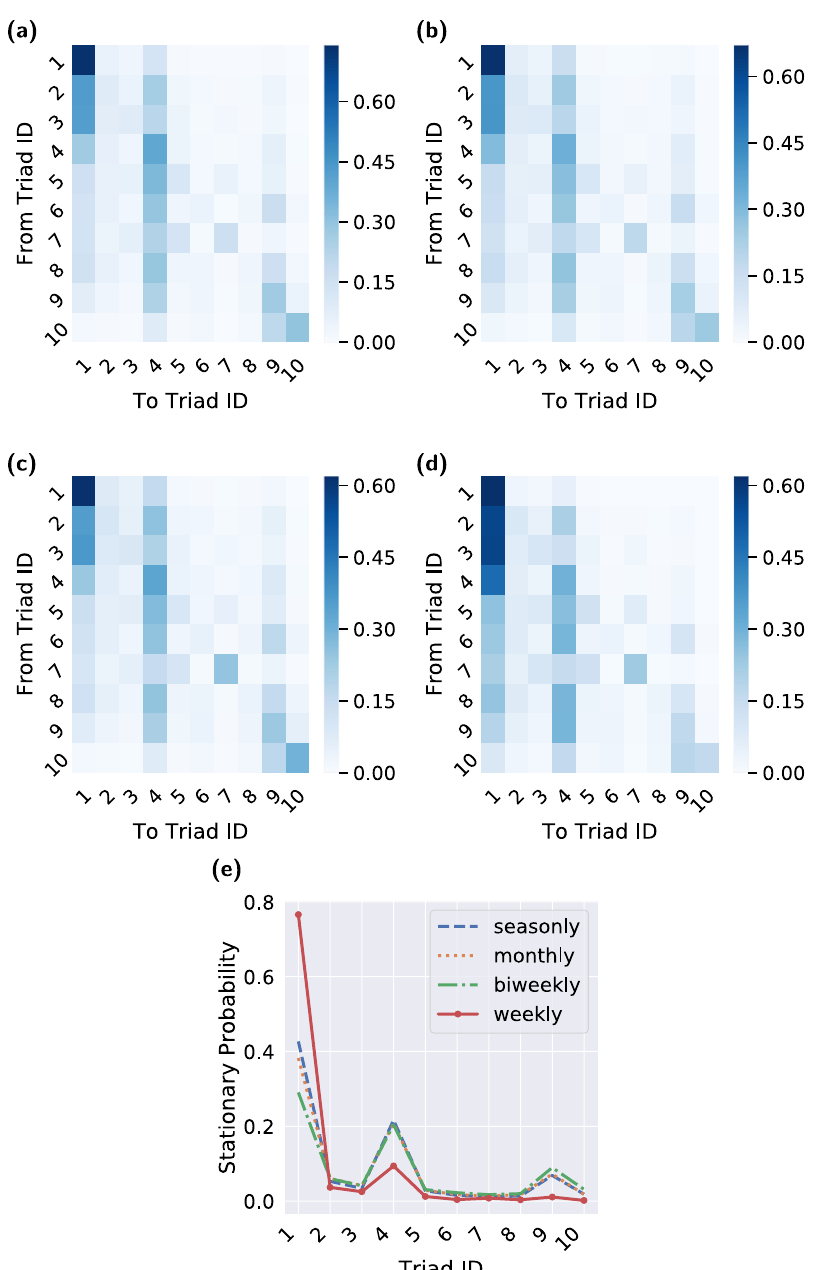
Fig. 3 Transition matrix for the core triads. Average probability transition matrix only for the core triads 1 in the Integrated Crisis Early Warning System (ICEWS) dataset by aggregating dynamic networks of a seasonally, b monthly, c biweekly, and d weekly period. The transition matrix is row-stochastic and its elements fall into (0, 1]. There are 138 possible triads; only the sub-matrix of the 10 operative triads is shown (given in Fig. 1e). e shows the probability of stationary distribution of the transition matrices, with the different aforementioned periods. The stationary distribution shows the state of the system under the condition that the Markov model persists. It appears that the probability transition matrix and stationary distribution are robust with respect to the choice of period